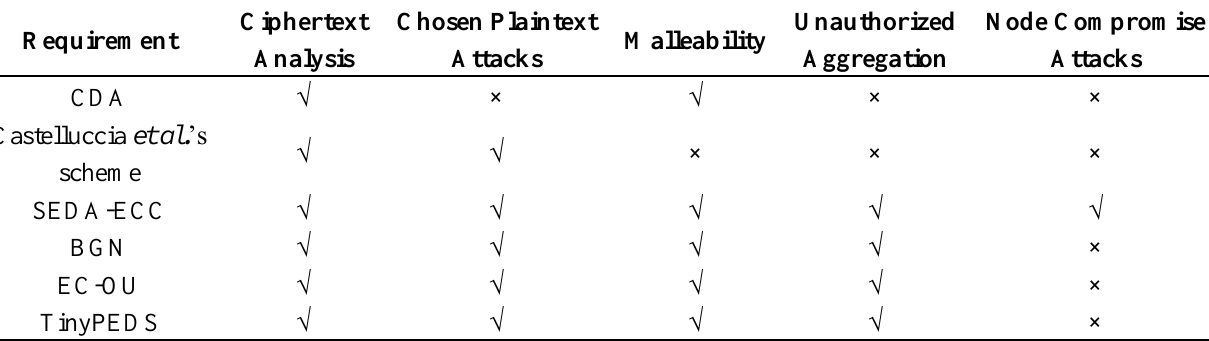
Table 1. Security comparisons.